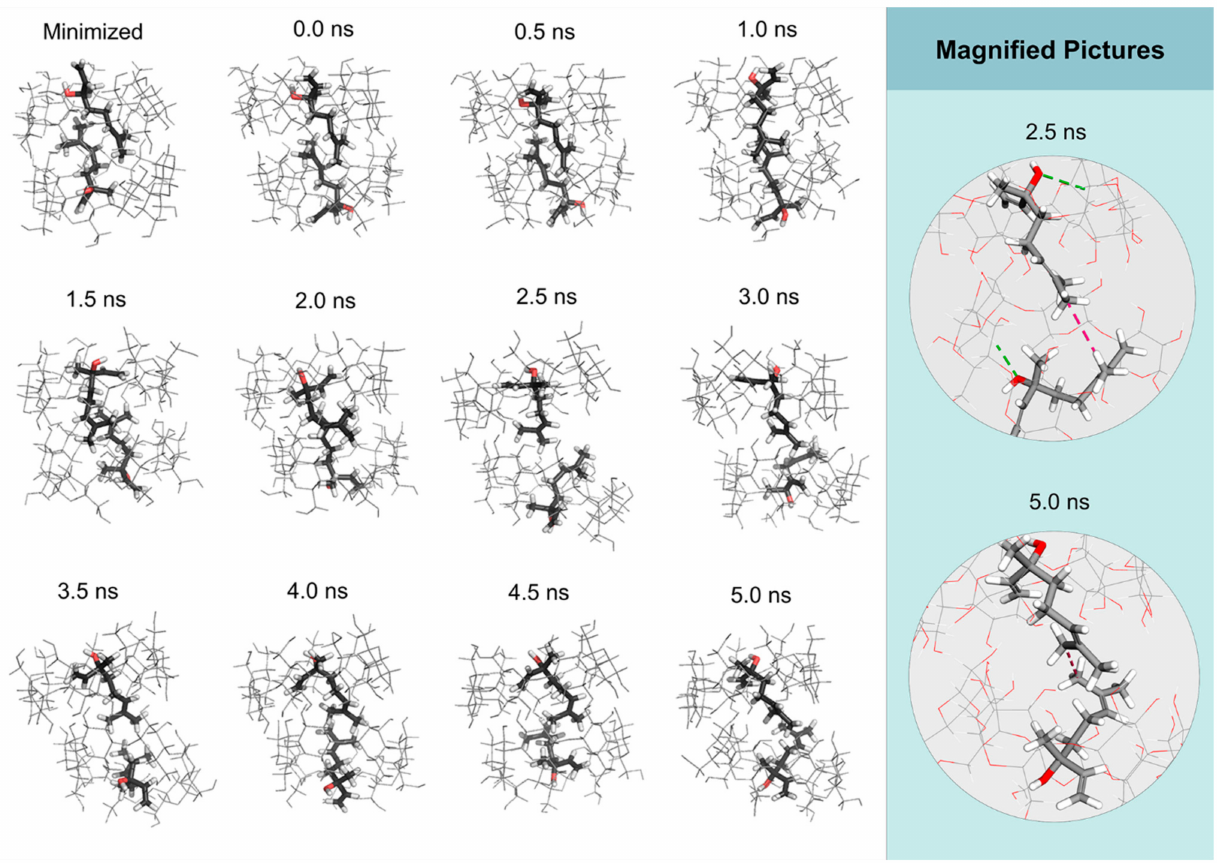
Figure 7. The MD snapshots of ( R )-linalool/BCD dimeric complex. BCD molecules are presented as line models. Linalool molecules are presented as stick models. The magnified picture of 2.5 and 5 ns snapshot are illustrated on the right to show the intermolecular bonding. The green and pink dashed lines refer to hydrogen bond and hydrophobic interaction,